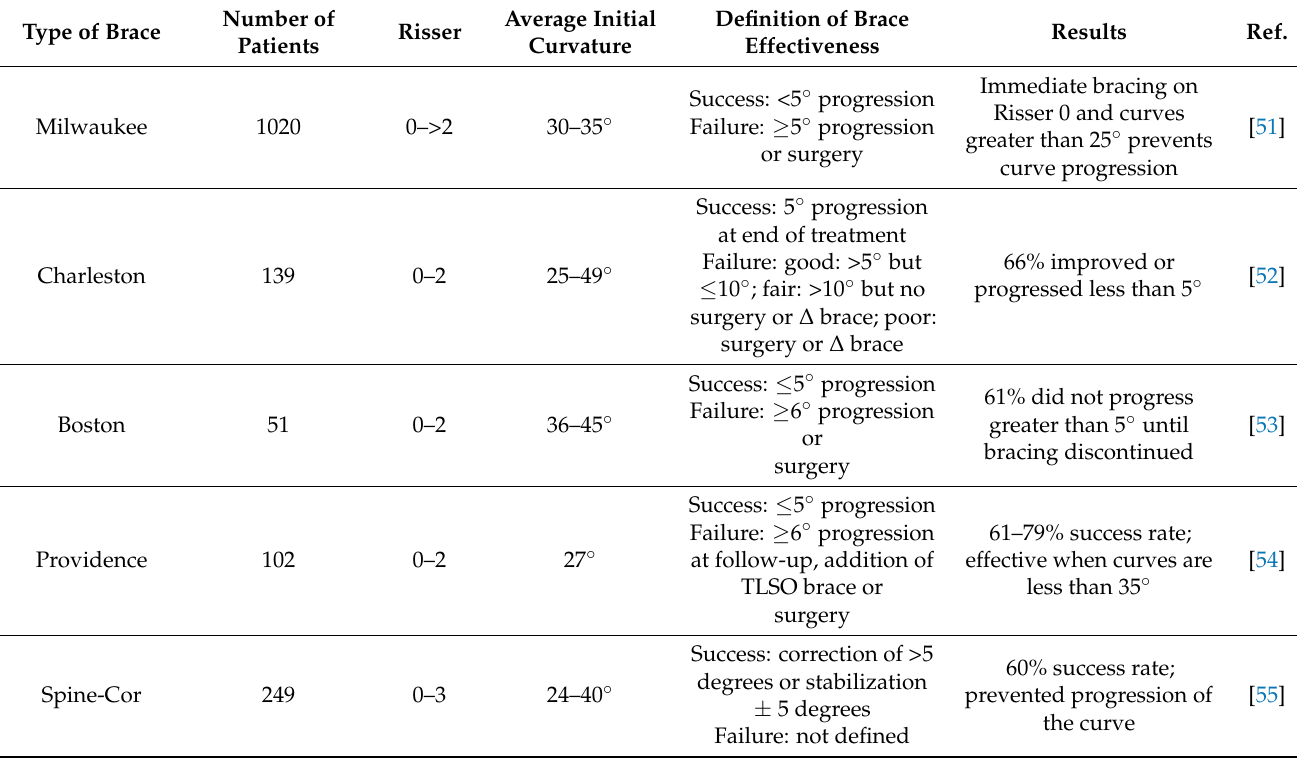
Table 3. Outcomes and conclusion from different bracing. Modified from [50].